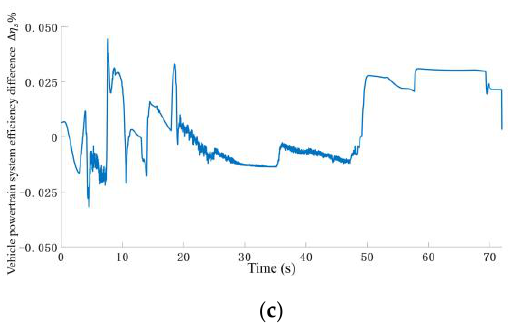
Figure 17. The efficiency difference diagrams: ( a ) The motor efficiency difference; ( b ) EMCVT Figure 17. The e ffi ciency di ff erence diagrams: ( a ) The motor e ffi ciency di ff erence; ( b ) EMCVT e ffi ciency efficiency difference; ( c ) Vehicle powertrain system efficiency difference. di ff erence; ( c ) Vehicle powertrain system e ffi ciency di ff